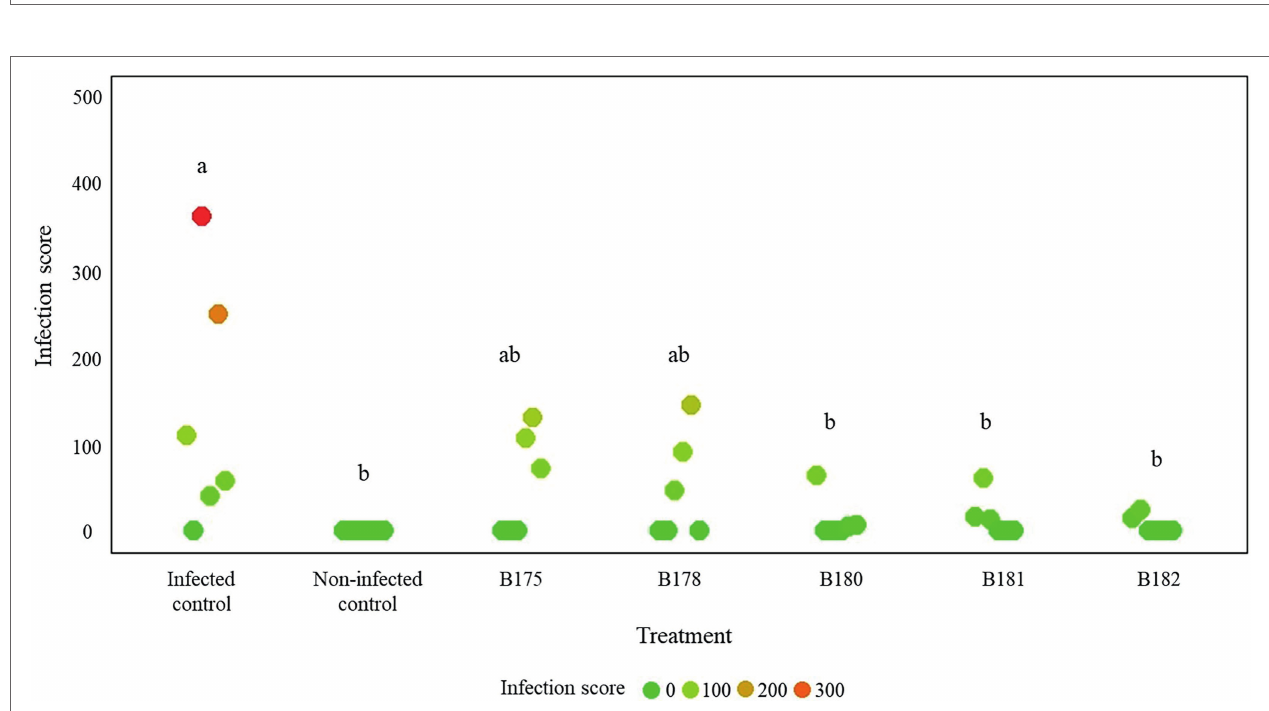
FIGURE 5 | Leaf disc assay of Streptomyces’ cell-free filtrates against Phytophthora infestans . (A) Bar chart showing average mycelium growth area percentage (measured by Image J). Bars are averages of 20 leaf discs from two independent experiments with standard errors. Asterisks represent statistically significant differences in comparison to the non-treated, infected control ( *** p < 0.001 and * p < 0.05). (B) Representative pictures of the leaf discs from the non-treated, infected (Ctrl i) and non-infected controls (Ctrl n-i), as well as from 50% of strains’ cell-free filtrate showing different levels of disease inhibition. Pictures were taken 5 days after infection.